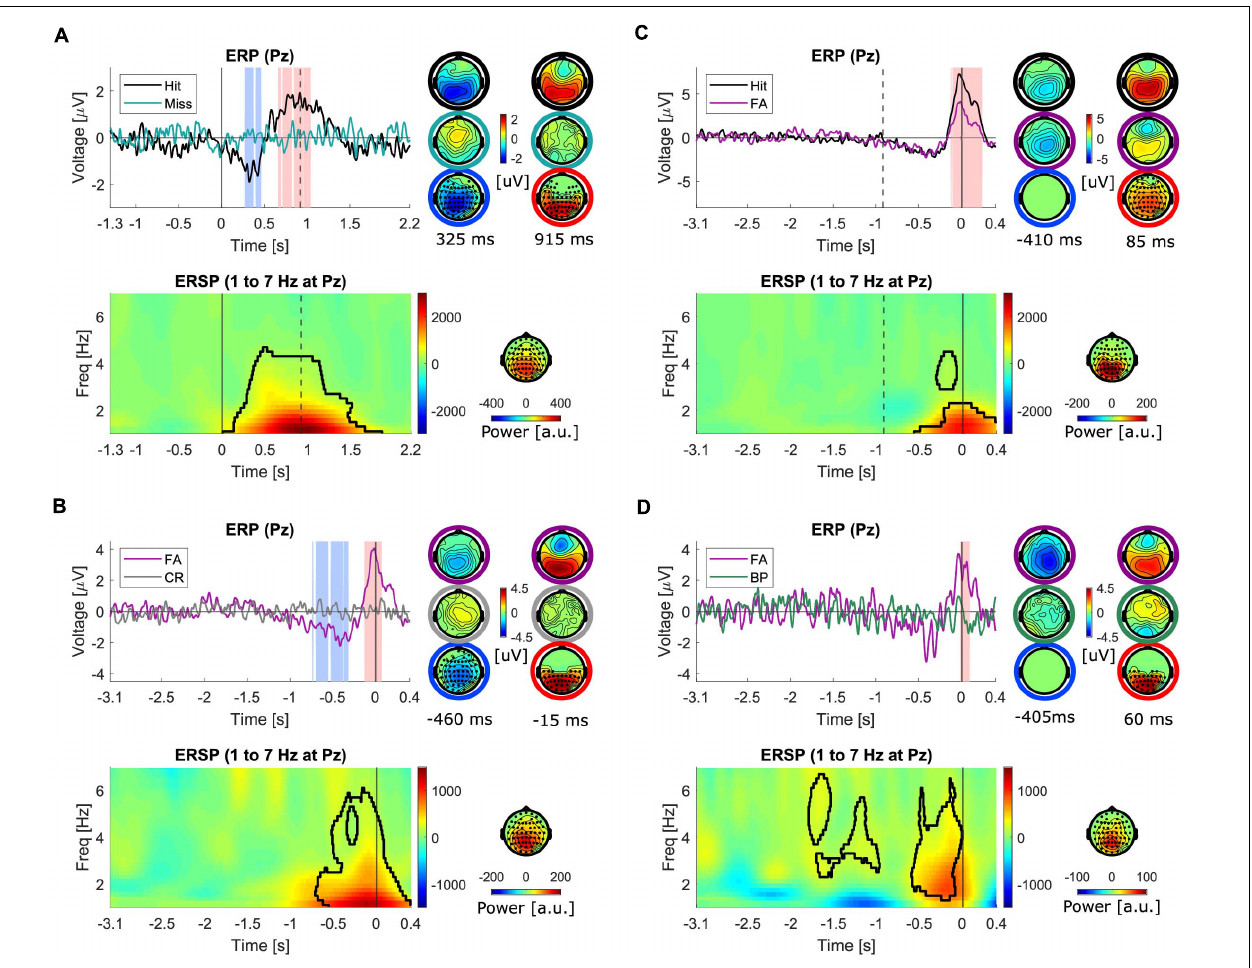
FIGURE 4 | Comparison of ERPs and ERSPs (1–7 Hz) between different trial types. Time is denoted on the x -axis in seconds. ERSP plots reflect differences between the two conditions. All the plots represent the signals at electrode “Pz.” The shaded intervals in light red and blue mark the significant interval with positive and negative differences between the two conditions. The topographies on the right of the ERPs represent the scalp distribution of the voltages corresponding to the two conditions separately (top two rows of topographies) at the time with strongest negative (left) and strongest positive differences (right) and the differences between conditions (bottom row of topographies). The marked electrodes with filled circles are part of the significant cluster. The black contour in the ERSPs marks the significant cluster and the topography maps show the scalp distribution of the significant cluster. (A) Hit-miss, aligned to stimulus-onset ( N = 16). The dashed vertical line marks the median reaction time. (B) FA-CR, aligned to response time ( N = 16) (C) Hit-FA, aligned to response time ( N = 16). The dashed vertical line marks the negative median reaction time (D) FA-BP, aligned to response time ( N =